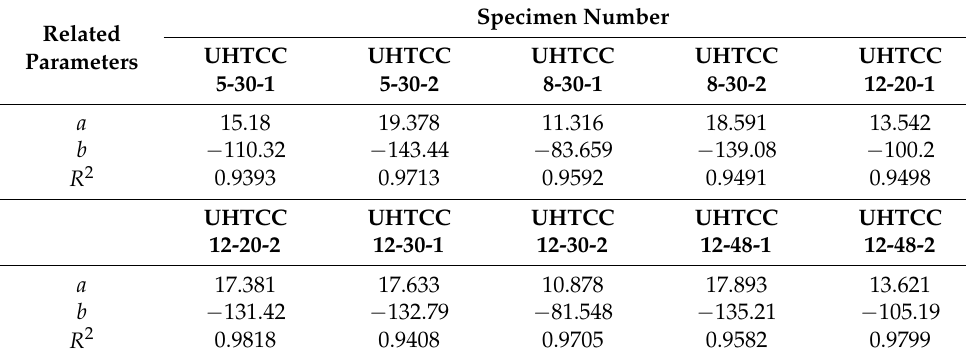
Table 11. PP-UHTCC Weibull regression parameters.